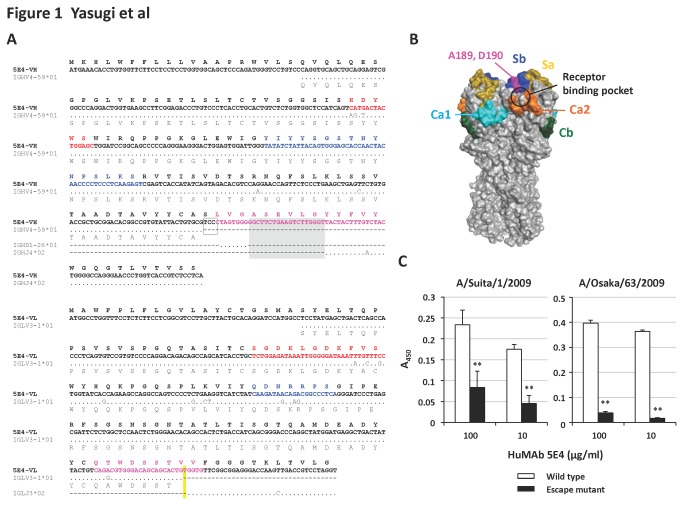
Characterization of HuMAb 5E4.(A) Nucleotide and amino acid sequences of the VH and VL of HuMAb 5E4. The closest germline sequences to the VH and VL of HuMAb 5E4 in the NCBI database, found by IgBLAST software, were aligned. Complementarity-determining regions (CDRs) are indicated in red, blue and pink (CDRs 1, 2 and 3, respectively). V-D and D-J junctions in VH and V-J junctions in VL are highlighted in white, gray and yellow, respectively. (B) Epitope region of HuMAb 5E4 in structural model of HA in A(H1N1)pdm09. A trimer complex is shown in surface representation with the antigenic sites highlighted: Sa in yellow, Sb in blue, Ca1 in cyan, Ca2 in orange and Cb in green. The epitope regions, A189 and D190, are shown in pink. The receptor binding pocket is circled. (C) AC-ELISA using wild-type viruses (open bars) and escape mutants (solid bars) of A/Suita/1/2009 (left panel) and A/Osaka/63/2009 (right panel). MuMAb C179 and HuMAb 5E4 were used as the coating and detecting antibodies, respectively. All data are represented as the means ± s.d. of three independent experiments. Asterisks denote P<0.01.